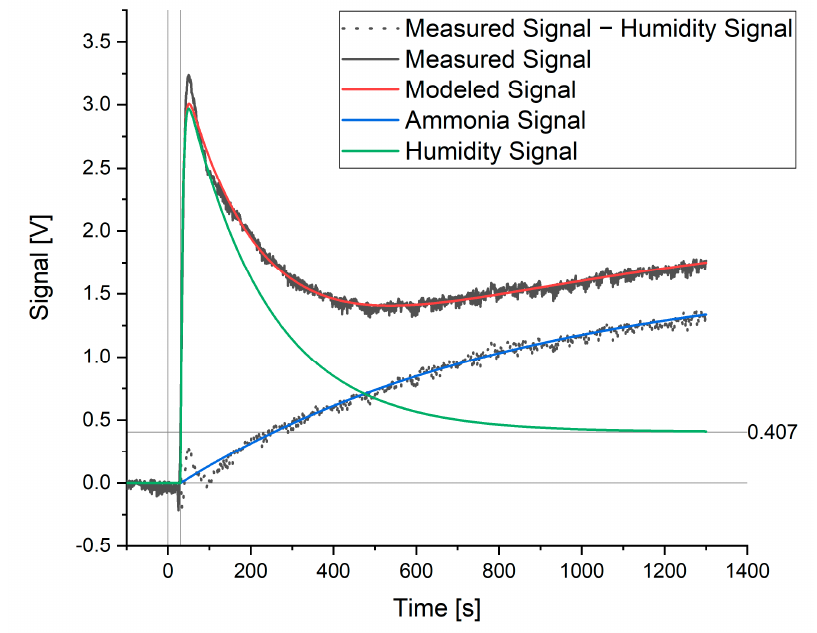
Figure 3. Modeled and measured signals for a sample containing 60 ppm ammonia.